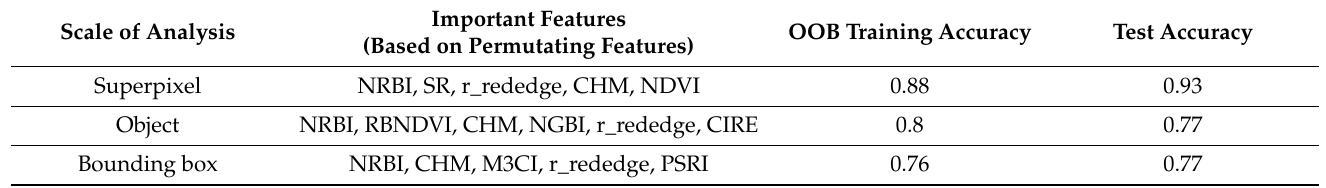
Table 8. Features important in the best performing model (Euc spp. aggregated) at each scale. Features listed had a permutation importance greater than 0 on the training set.